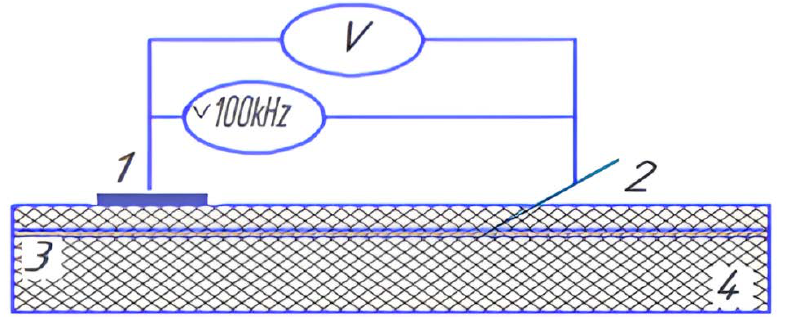
Figure 1. Schematic setting of the electrode system. 1, 2—electrode system, 3—blood vessel, and 4— the surrounding tissues. Table 1. The electrical resistivity of forearm biological tissues at 100 kHz frequency.